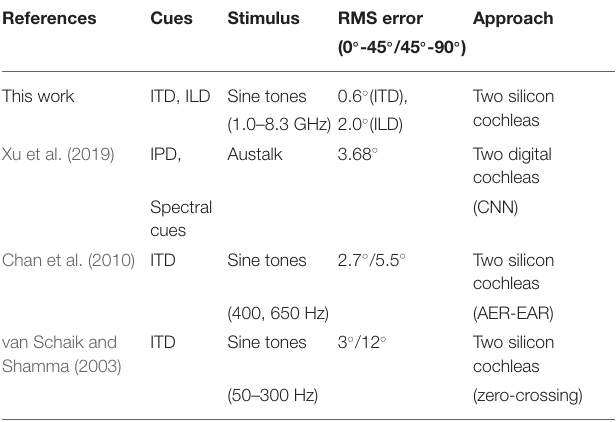
TABLE 2 | Performance summary compared with prior